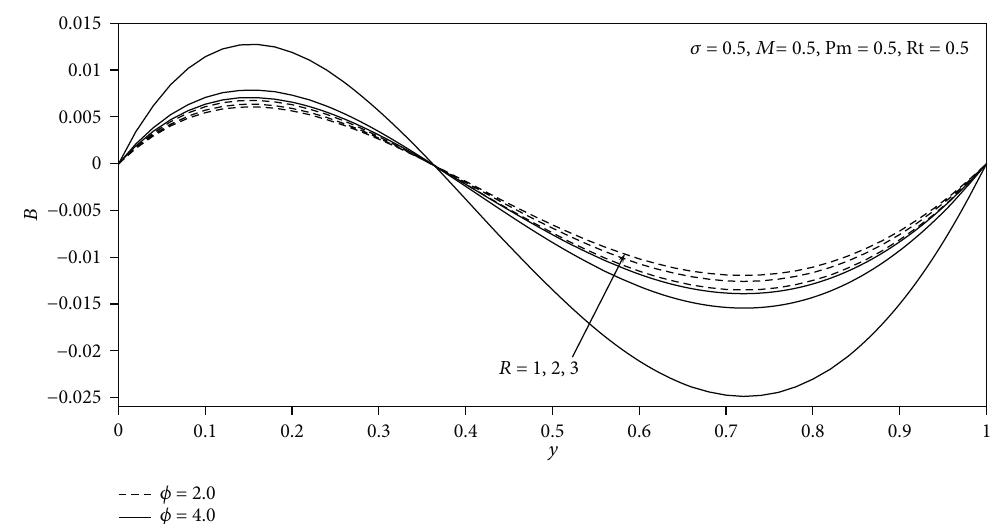
Figure 4: Velocity pro fi le for di ff erent values of σ and Pm .